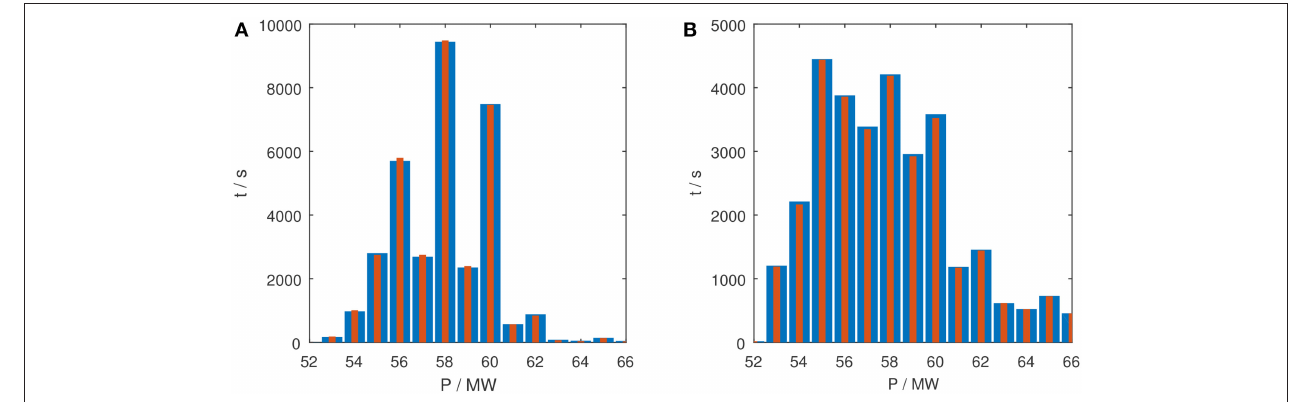
FIGURE 2 | Mean value (A) and standard deviation (B) of original B772 data (blue) and random process (red) defined in